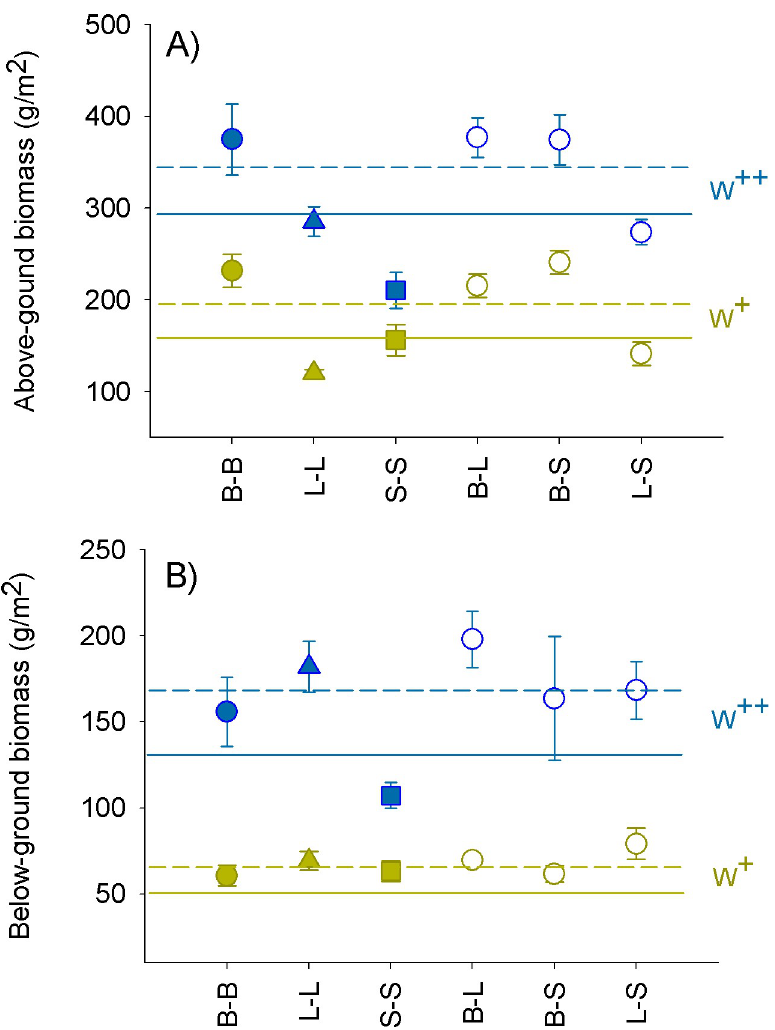
Fig 3. Culture biomass as a function of species combination and watering. Above-ground (A) and below-ground (B) biomass (average ± 1 SE; n = 4). B-B, L-L, and S-S: monocultures of B . retusum , L . spartum and S . tenacissima , respectively; B-L, B-S, and L-S: bi-specific cultures of each pair of species, with B, L and S representing B . retusum , L . spartum , and S . tenacissima , respectively. Solid line: average biomass for monospecific cultures; dashed line: average biomass for bi-specific cultures.